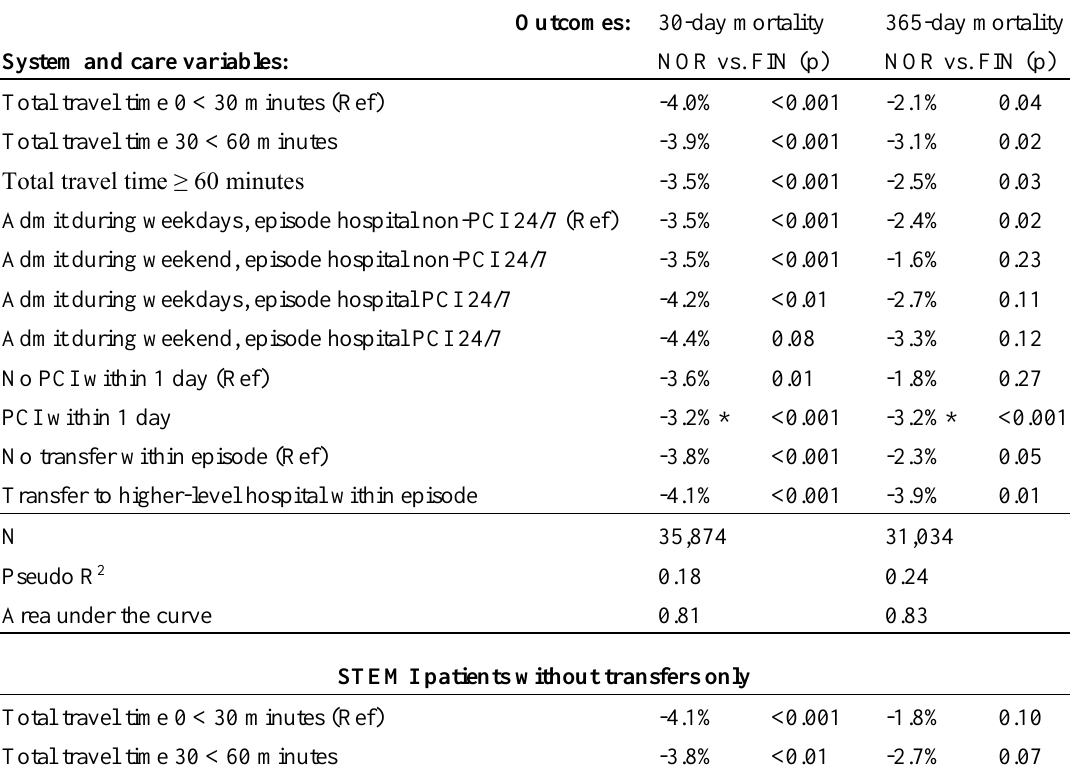
Table 2: Marginal mortality differences in percentage points, Norway (NOR) vs. Finland (FIN) and p-values (p), for different categories of system and care variables for the STEMI patients All STEMI patients Outcomes: 30-day